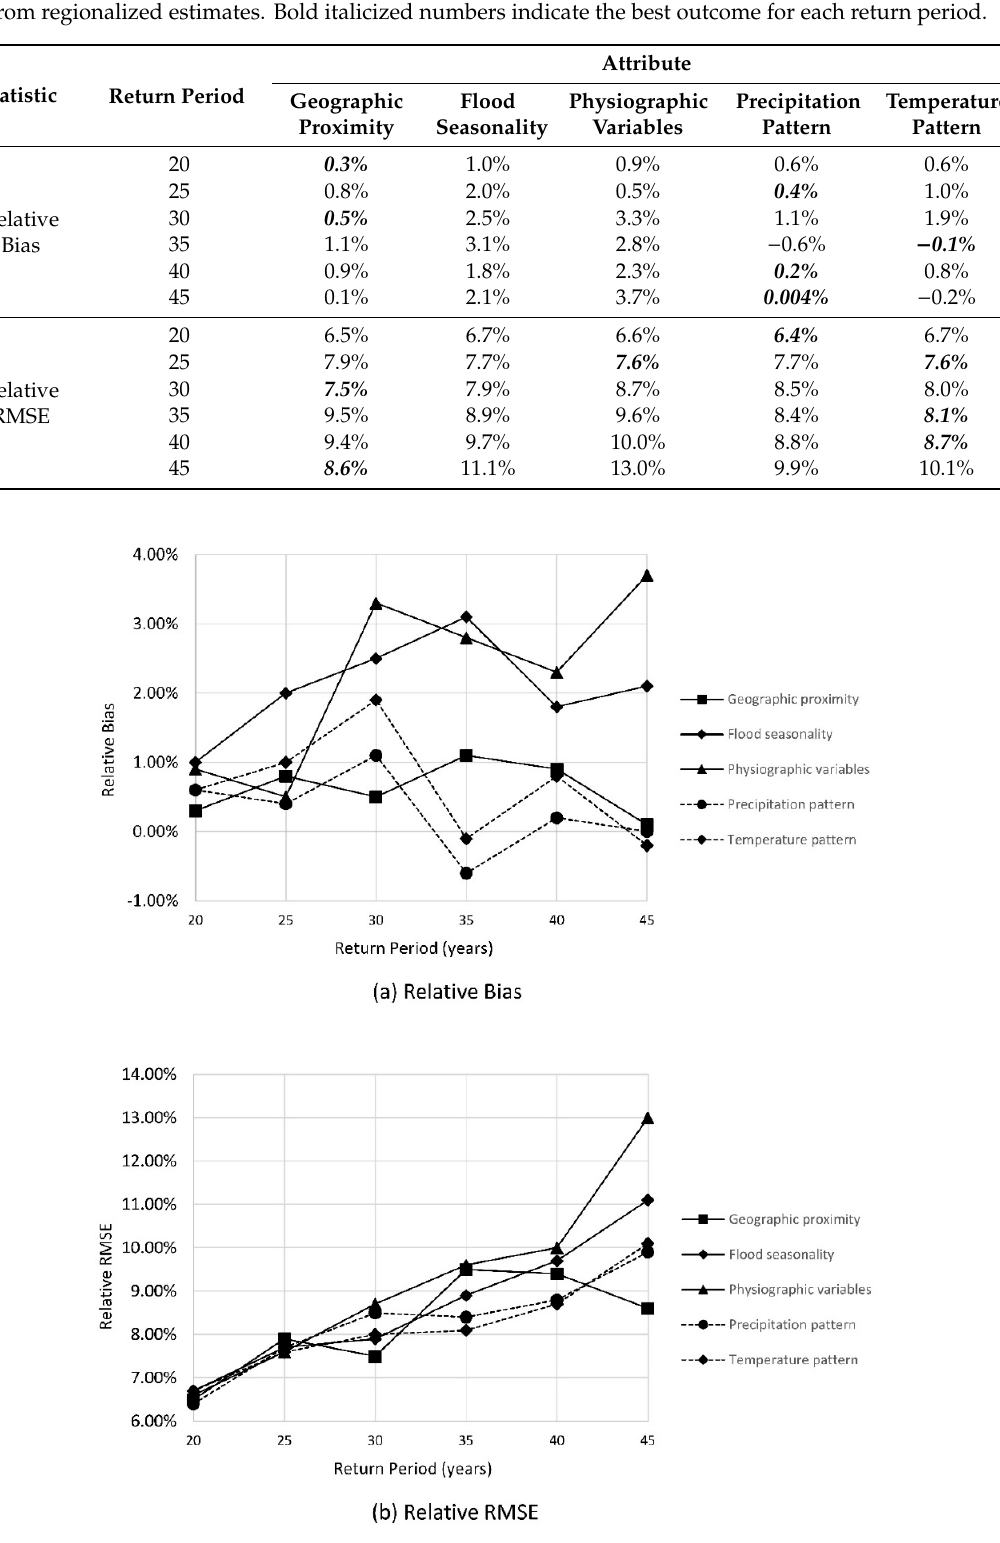
Table 4. Relative bias and relative RMSE performance measures (in percentages) for quantiles produced from regionalized estimates. Bold italicized numbers indicate the best outcome for each return period.